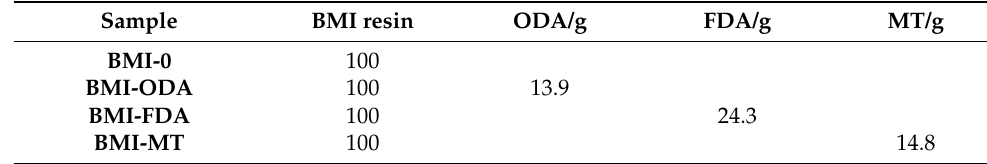
Table 1. Formulations (Mass Ratio) of BMI-NH 2 .